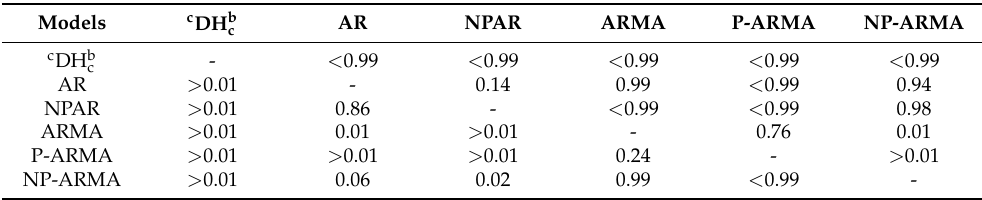
Table 8. Pakistan’s electricity consumption (kWh): results ( p -value) of the DM test for the bestpro- posed models versus the literature and the benchmark models given in Table